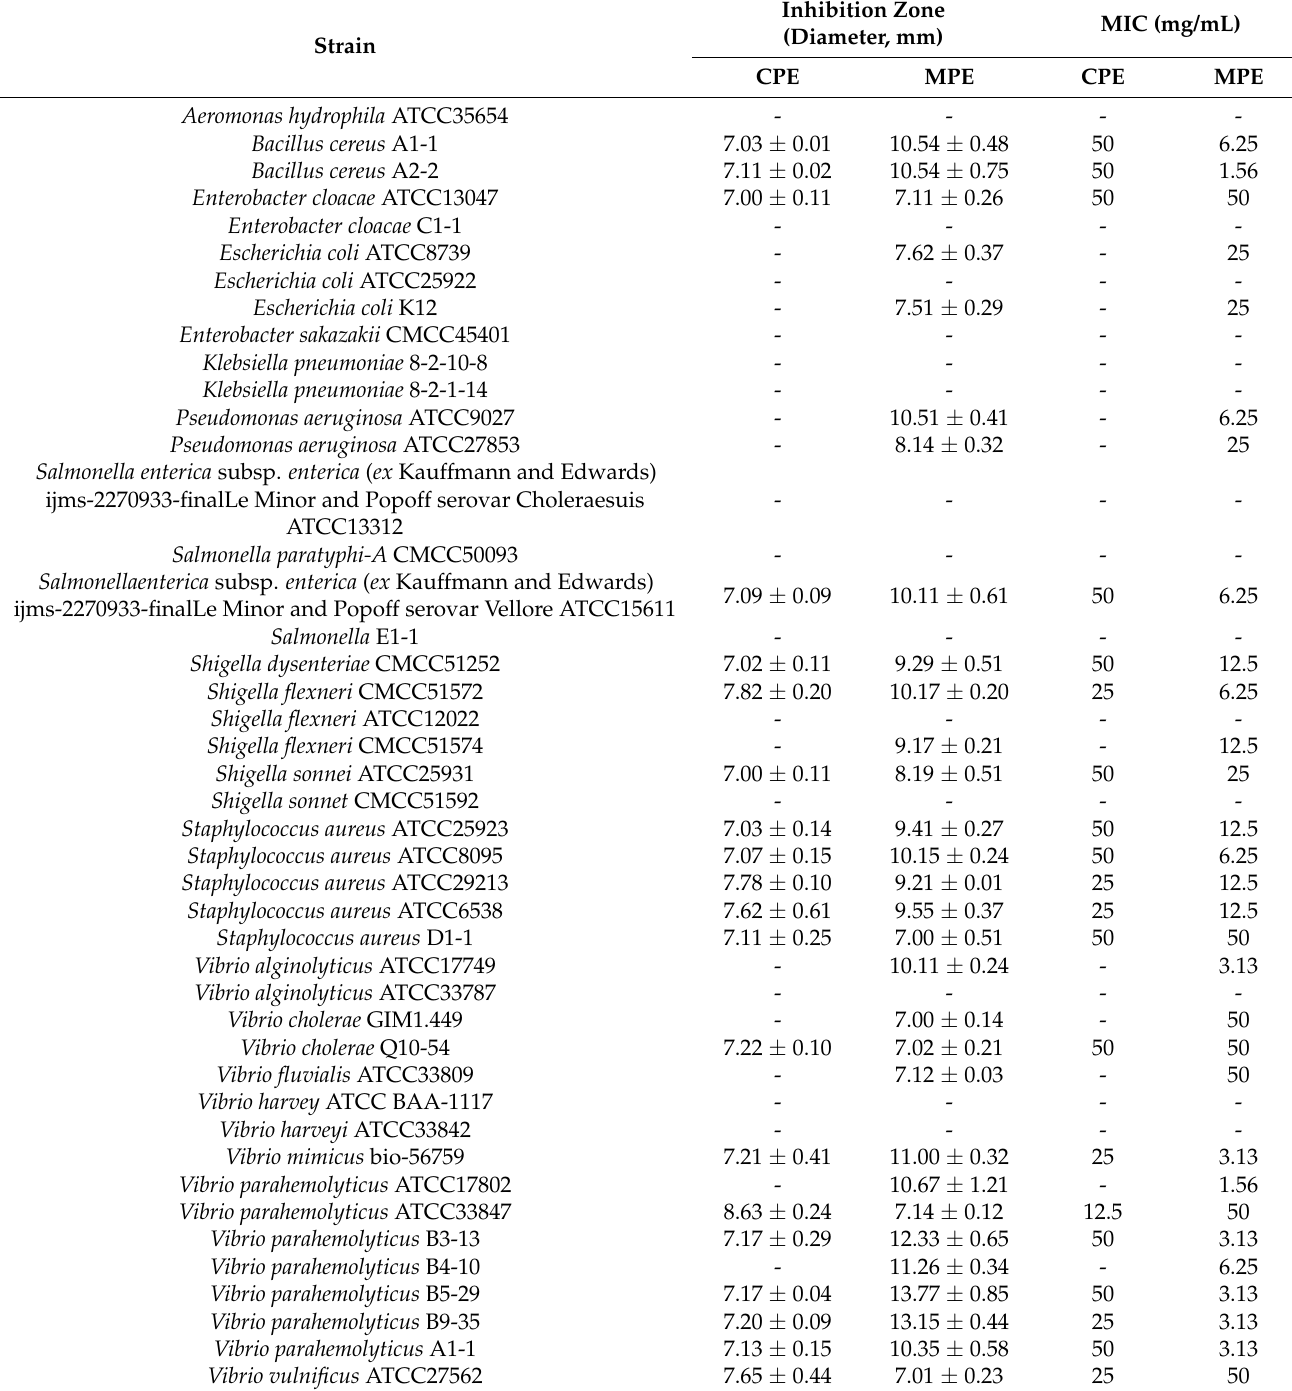
Table 1. Antibacterial activity of crude extracts from P. kleiniana Wight et